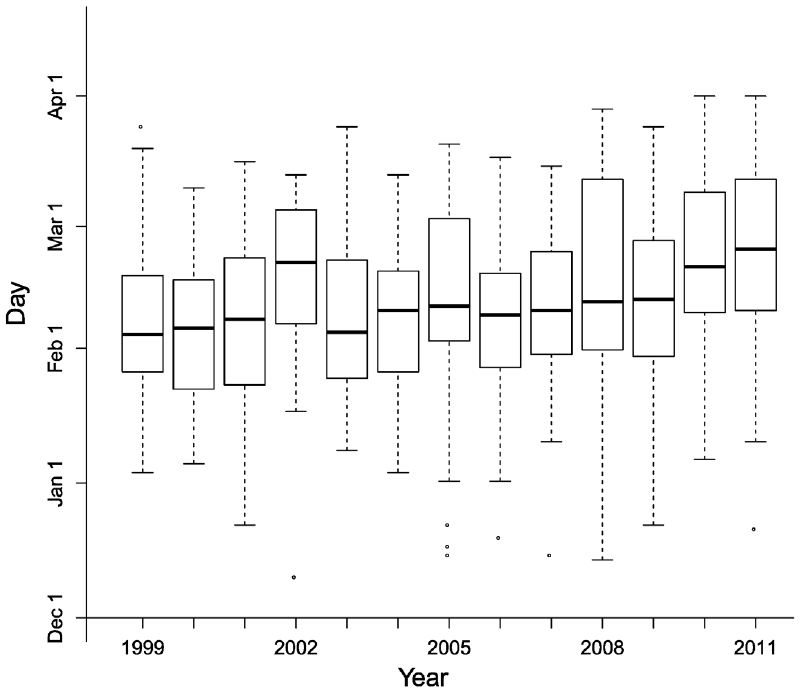
Figure 1. Timing of hibernation surveys across years. Box plots showing date of hibernacula surveys during 1999–2011.